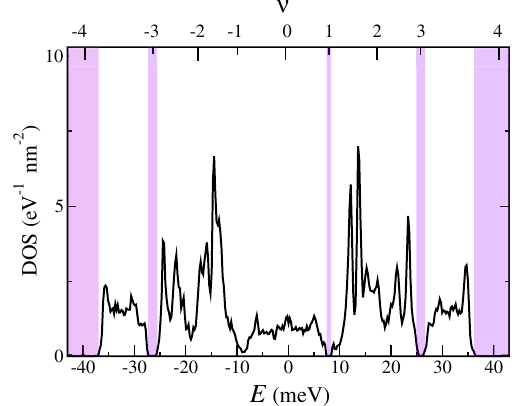
FIG. 11. Electronic density of states with a multicomponent lattice distortion obtained by freezing a combination of the modes at the three inequivalent M points. Band gaps at ν ¼ þ 1 ; (cid:2) 3 ; (cid:2) 4 are highlighted in violet. The mean displacement per atom is 1.7 boundary phonons that enlarge the unit cell, and thus open gaps at the boundaries of the folded Brillouin zone.